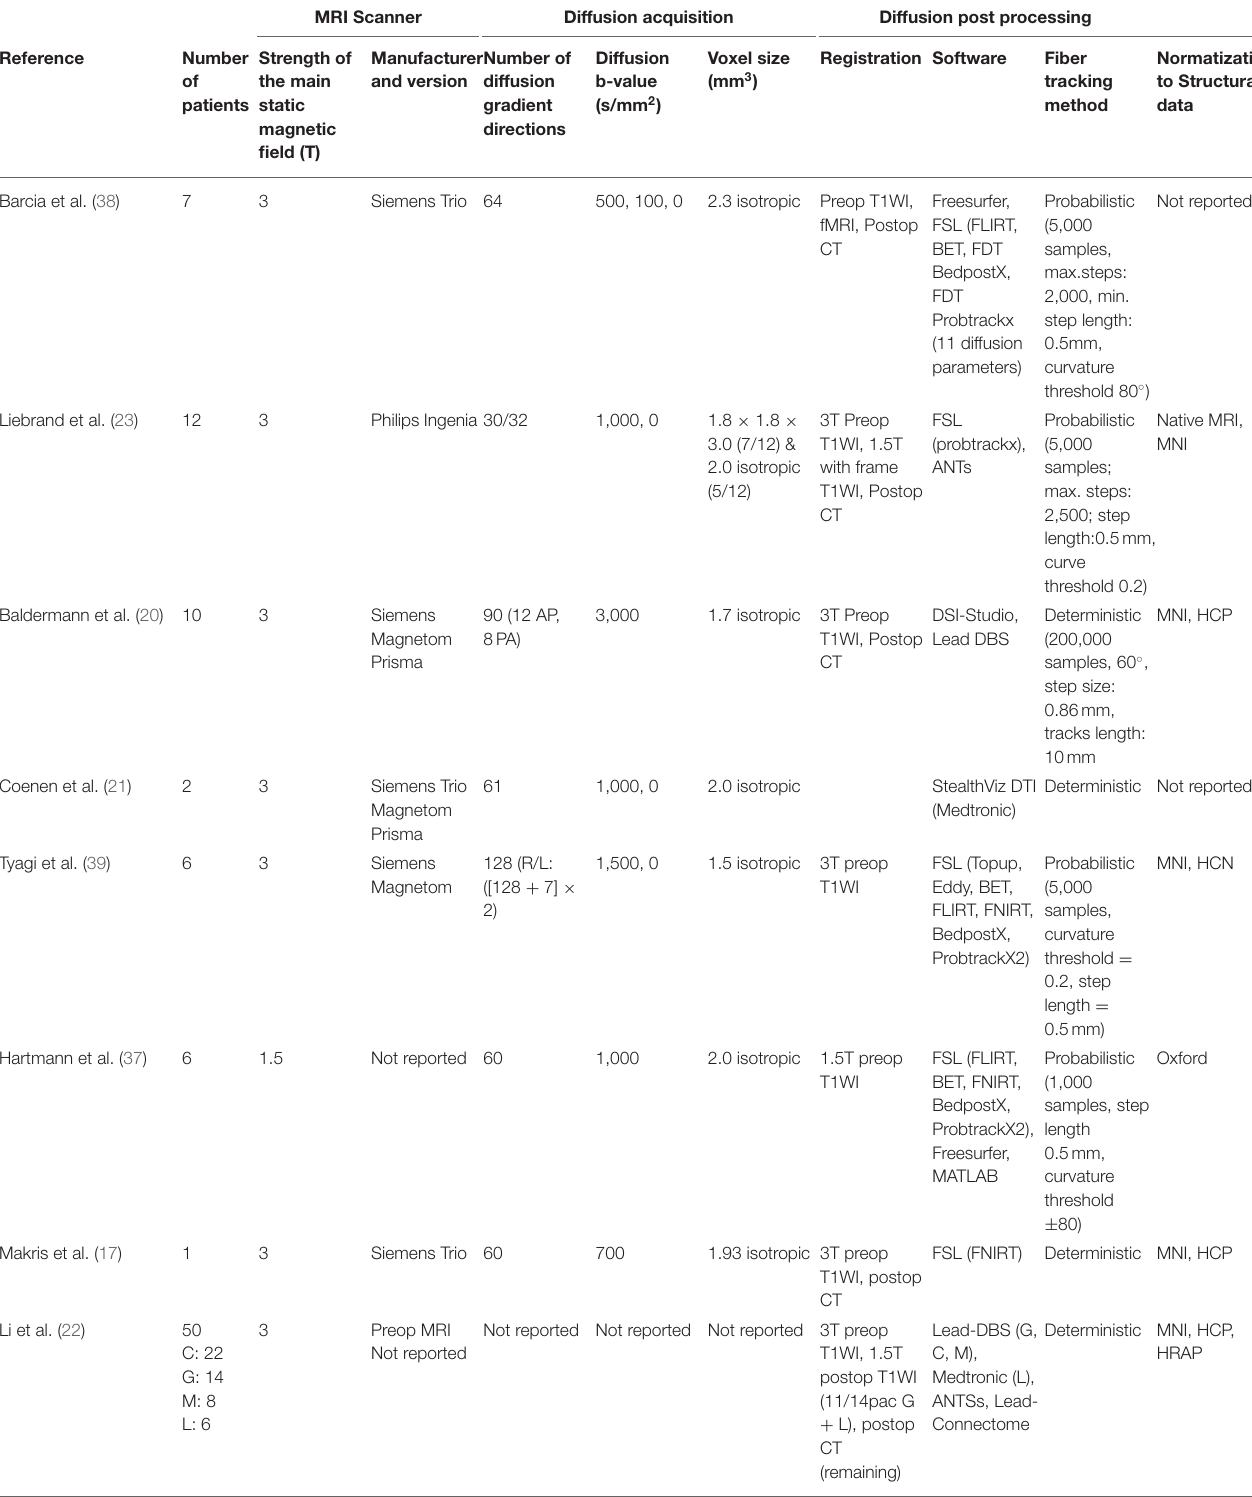
TABLE 2 | Characteristics of imaging acquisition, processing, and